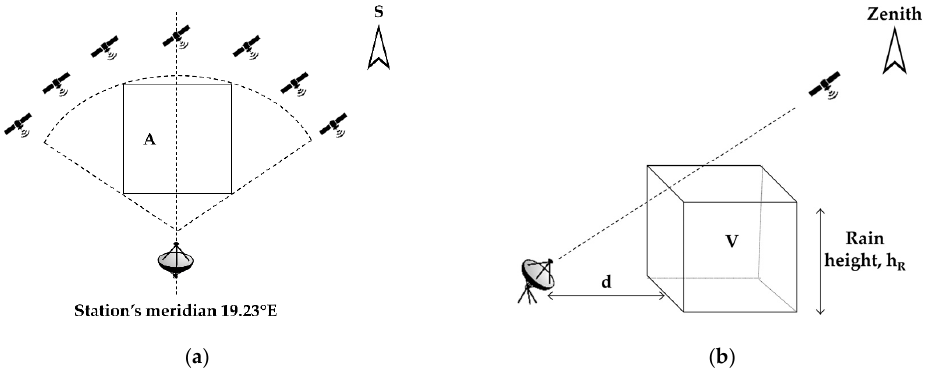
Figure 5. ( a ) Top view of the monitored area A ; ( b ) distance d of the receiver station from the monitored volume V .